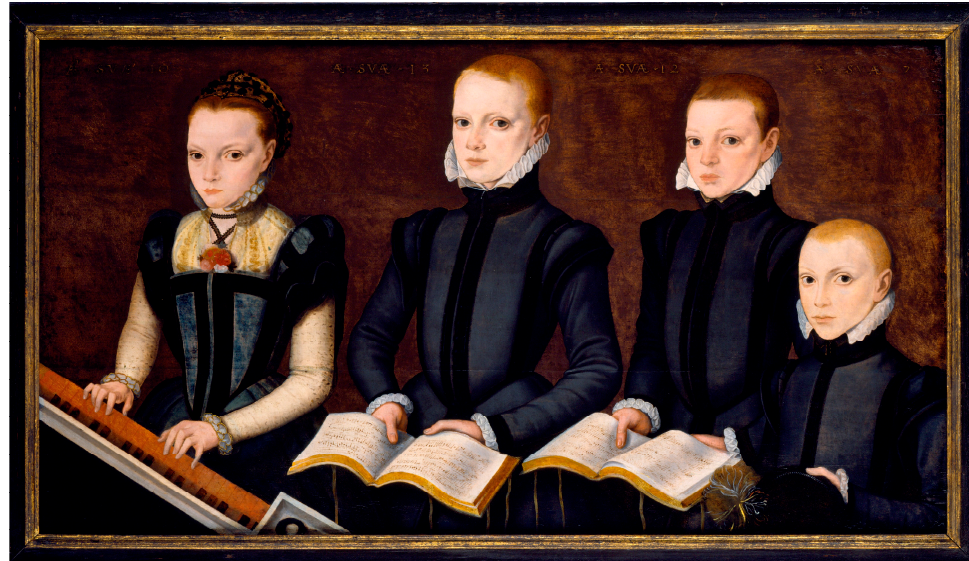
Figure 1. Master of the Countess of Warwick, Four Children Making Music, oil on panel, c. 1565 (Private Collection: by kind permission of the Weiss Gallery).